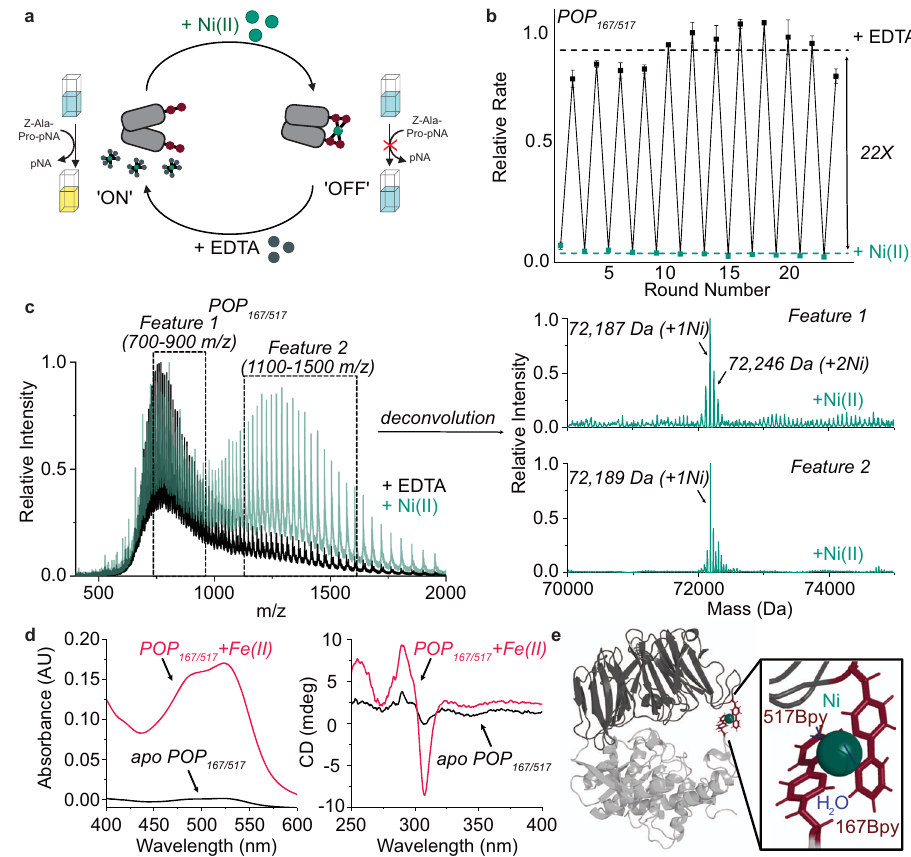
Fig. 4 Switching and characterization of POP 167/517 . a Assay for Ni(II)-dependent switching. b Ni(II)-dependent switching as measured by the relative rate of Z-Ala-Pro- p NA hydrolysis upon addition of Ni(II) (green points) or EDTA (black points); average rates are shown as green or black dashed lines, respectively. Data points are averages of triplicate reactions and error bars represent standard deviations. c Intact protein ESI-MS data for POP 167/517 in the presence of excess EDTA (black) or Ni(II) (green). Raw MS data (left) was deconvoluted (right) using m/z windows of either 700 – 900 or 1100 – 1500 for the Ni(II)-treated protein. d UV – Vis (left) and CD (right) spectra for apo (black) or Fe(II)-treated (pink) POP 167/517 showing expected MLCT transition and intraligand charge transfer, respectively, in the presence of Fe(II). e A representative structure of Ni(II)-bound POP 167/517 from MD simulation shows coordination of two BpyAla residues and two waters to the Ni(II) center. Source data are provided as a Source Data fi